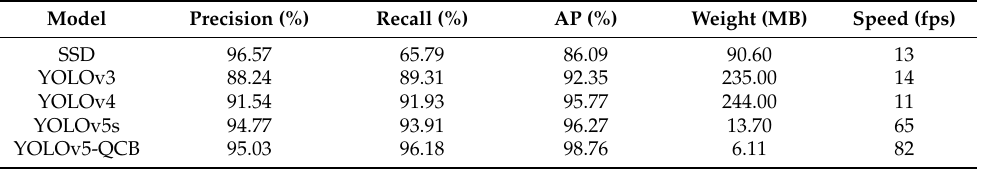
Table 5. Comparison of the performance of several detection